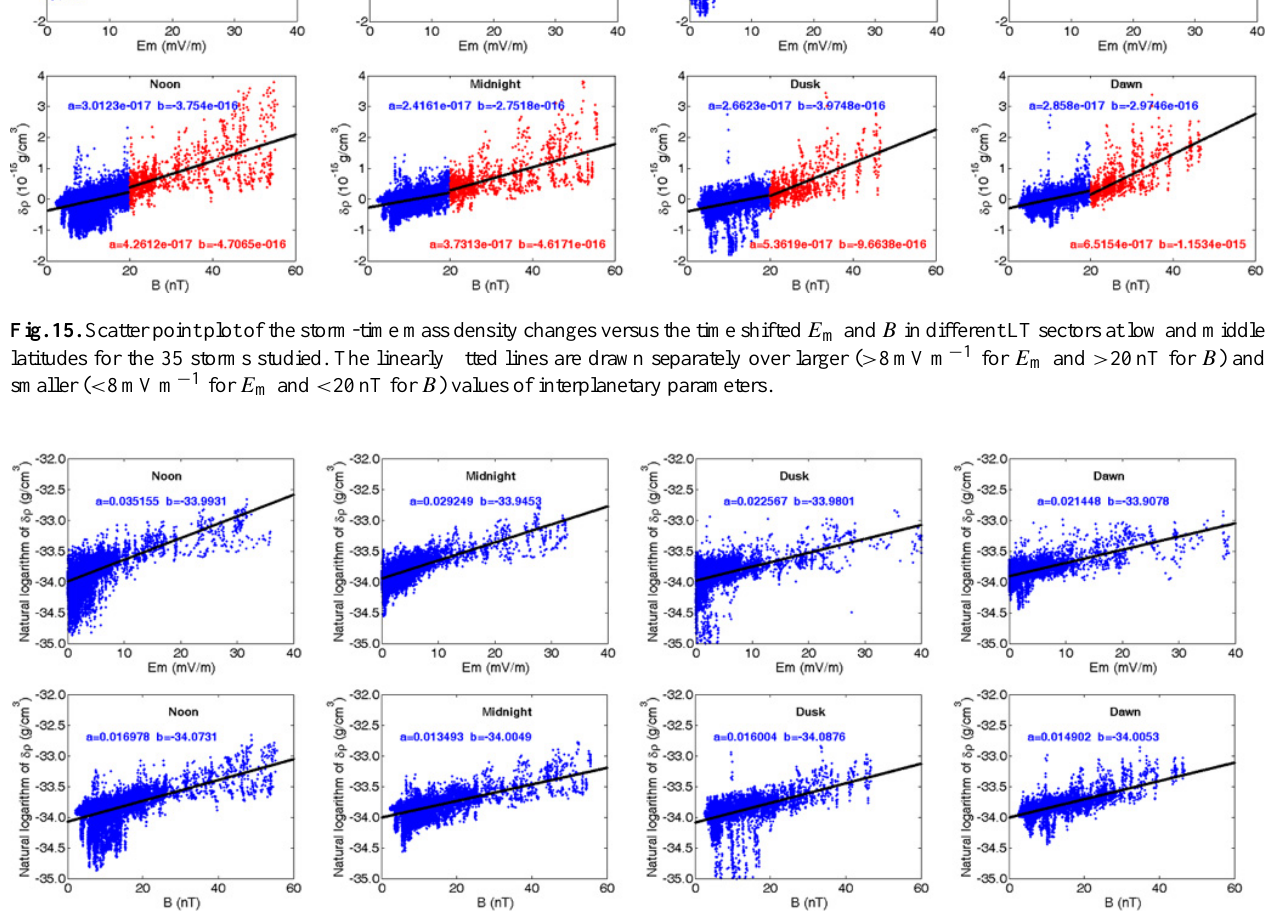
Fig. 16. Scatter point plot of the natural logarithm of storm-time mass density changes versus the time shifted E m and B in 4 different LT sectors at low and middle latitudes for the 26 CME storms